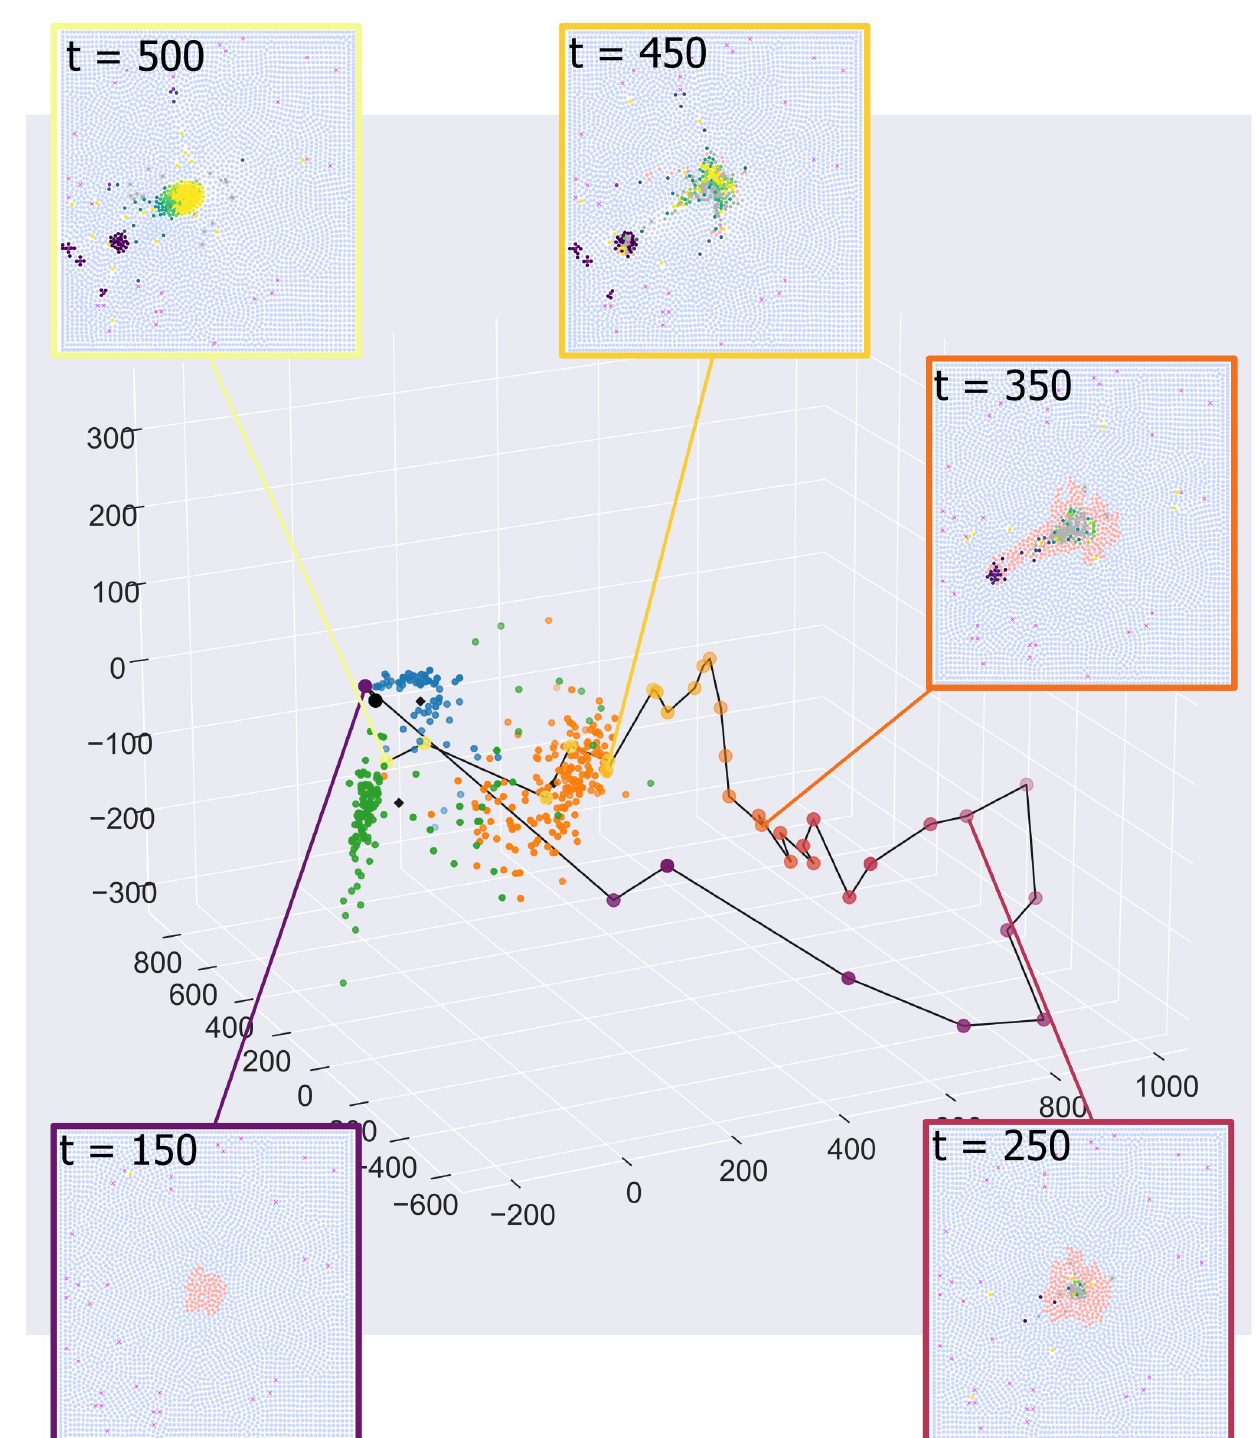
Fig 9. Dynamic evolution of an ABM simulation through PCA space. A single simulation can exhibit Equilibrium ( t = 150), Escape ( t = 350, 450) or Elimination ( t = 500) at different times. These changes are captured by the movement of the PCF signature through PCA space.